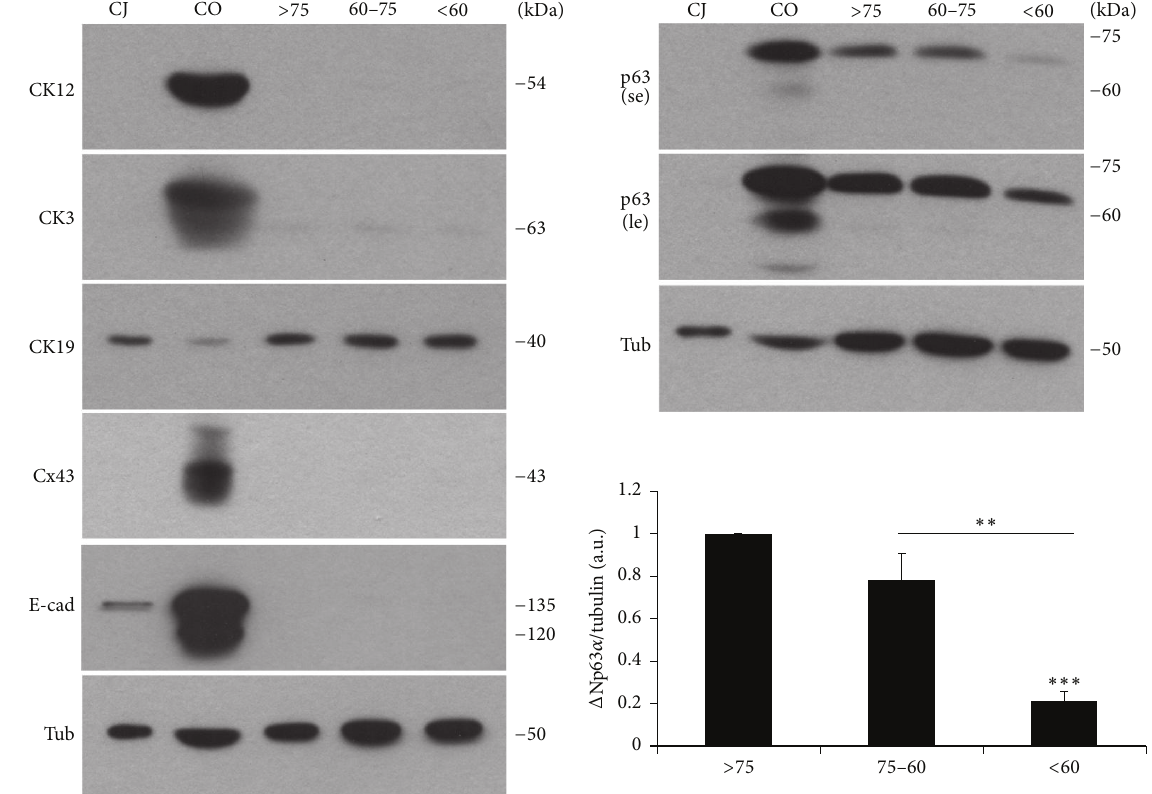
Figure 2: Comparative WB analysis of corneal progenitor markers and differentiation markers in LSC pools. No protein expression was detected for CK12, CK3, Cx43, or E-cad in each LSC pool, whereas expression was seen for CK19. Various isoforms of p63 were also present in the corneal cells (CO), but only Δ Np63 𝛼 was seen in LSC, even at long exposure times. The graph shows the densitometric analysis of Δ Np63 𝛼 . Results are presented as mean ± SE from 3 independent experiments. Statistical analysis performed using two-tailed Student’s 𝑡 -test ( ∗∗ 𝑝 < 0.01 ; ∗∗∗ 𝑝 < 0.001 ). CJ: conjunctiva cells; CK: cytokeratin; CO: corneal epithelial cells; Cx: connexin; E-cad: E-cadherin; le: long exposure; se: short exposure; tub: